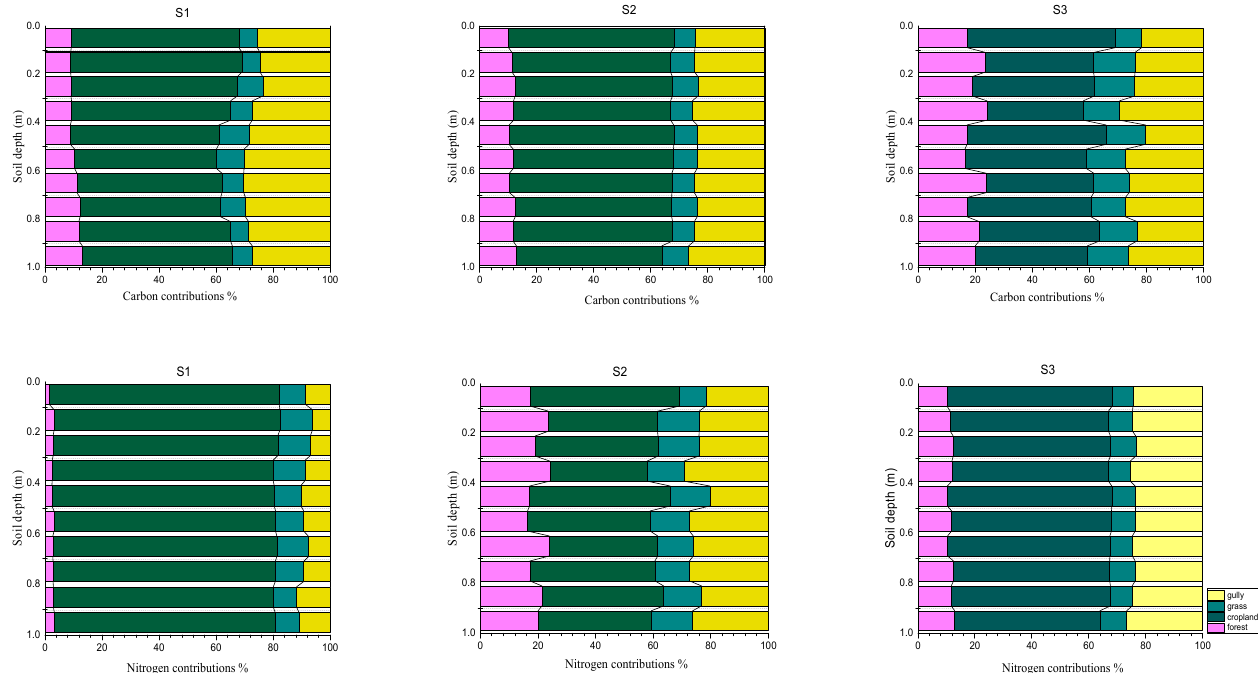
Figure 7. Percentage contributions of each source soils to C and N contents in sediment profiles deposited at three dam